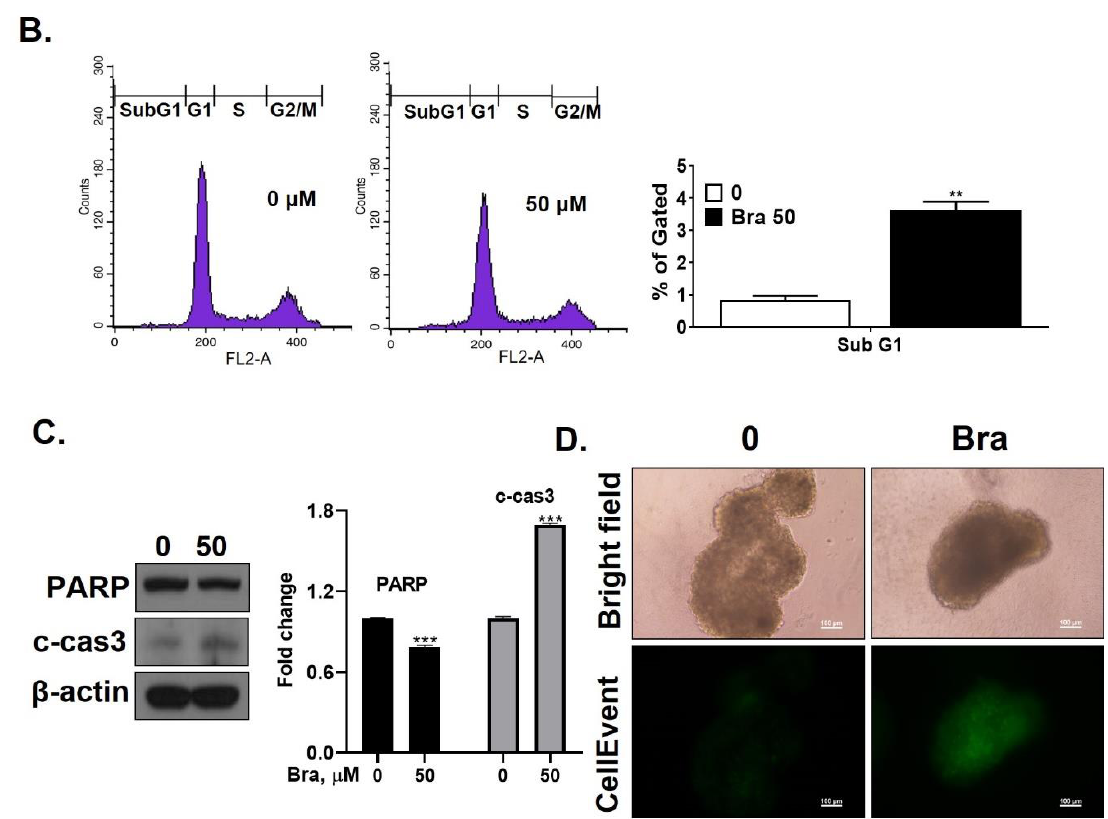
Figure 4. Inhibitory e ff ect of brassicasterol on cell growth in LNCaP cells. ( A ) 10 and 50 µ M of Brassicasterol treated to LNCap Cells for 5 days. The cells were stained with a crystal violet staining solution, and randomly chosen were photographed and resolved in 70% EtOH, and the absorbance was measured using a microplate reader. Data represent mean ± SD. (*) p < 0.05 compared with control. ( B ) Cell cycle analysis of brassicasterol in LNCaP cells. The LNCaP cells were treated with 50 µ M of Brassicasterol for 48 h and analyzed by flow cytometry. Bar graphs showed the quantification of subG1 (%). (**) p < 0.01 compared with control. ( C ) Brassicasterol-treated (50 µ M, 48 h) LNCaP cell lysates were prepared and subject to Western blotting for apoptosis makers (PARP and cleaved caspase-3). Bar graph represents the quantification of interest protein related to β-actin, presents as a fold change of control. (***) p < 0.01 (in comparison to control). ( D ) Inhibitory effect of brassicasterol